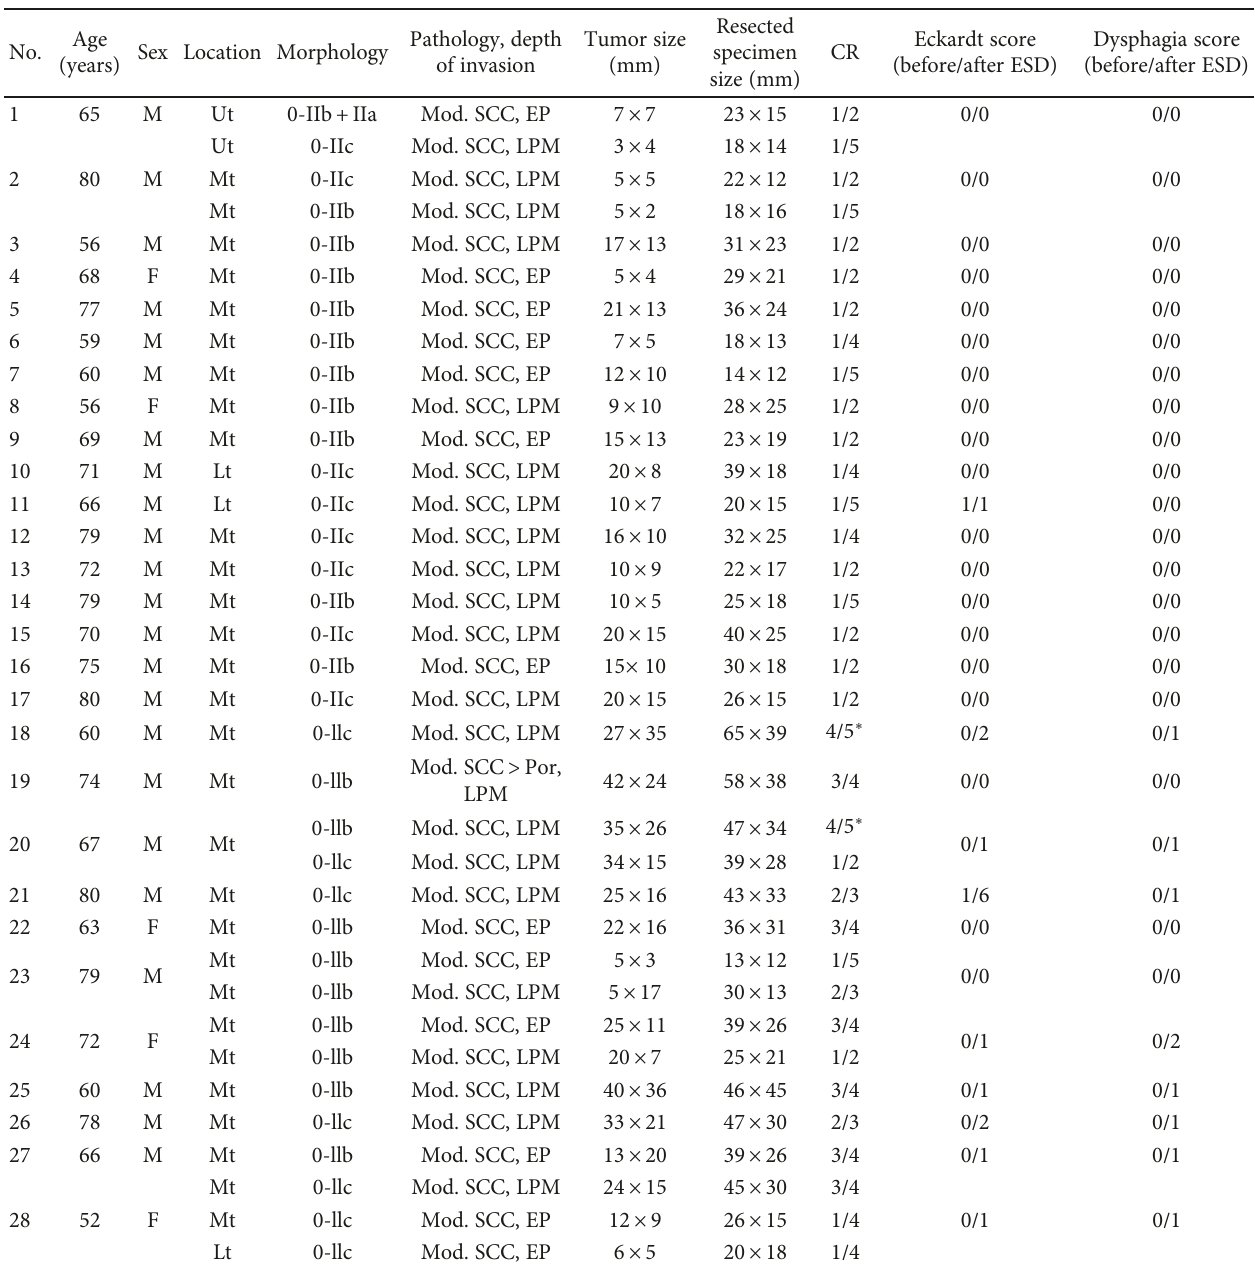
Table 2: Overview of patients ’ clinical